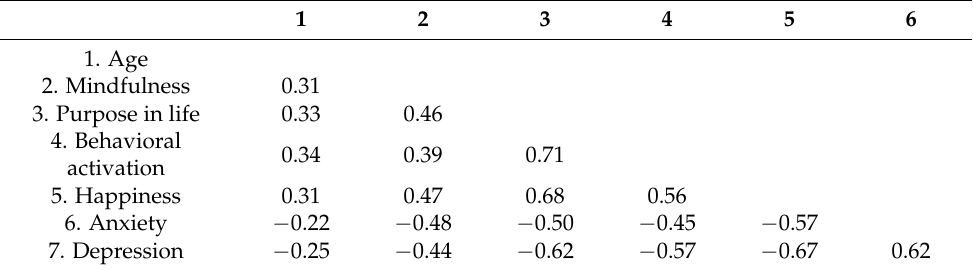
Table 2. Bivariate correlations among the study